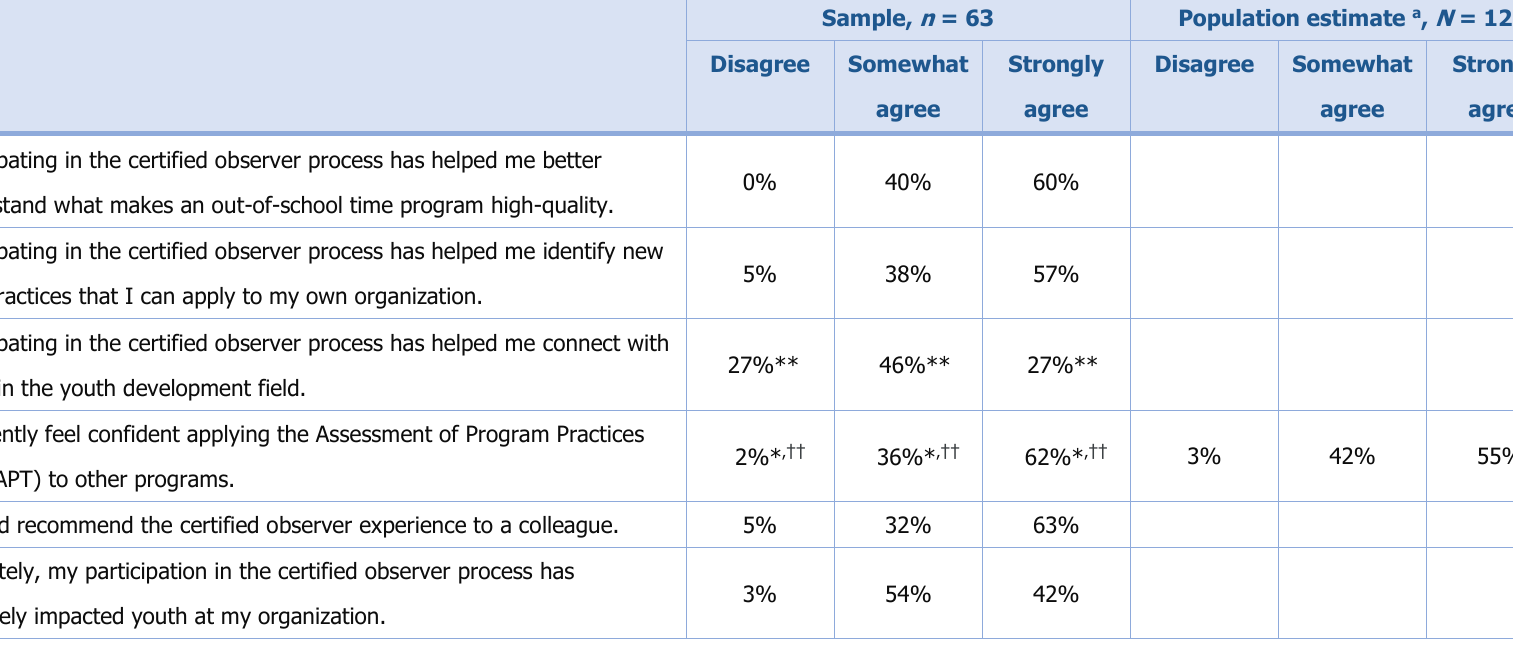
a Population adjustments were needed only when item responses varied by certification status or observation status, which were over-represented groups. Therefore, when adjusted, strong agreement level